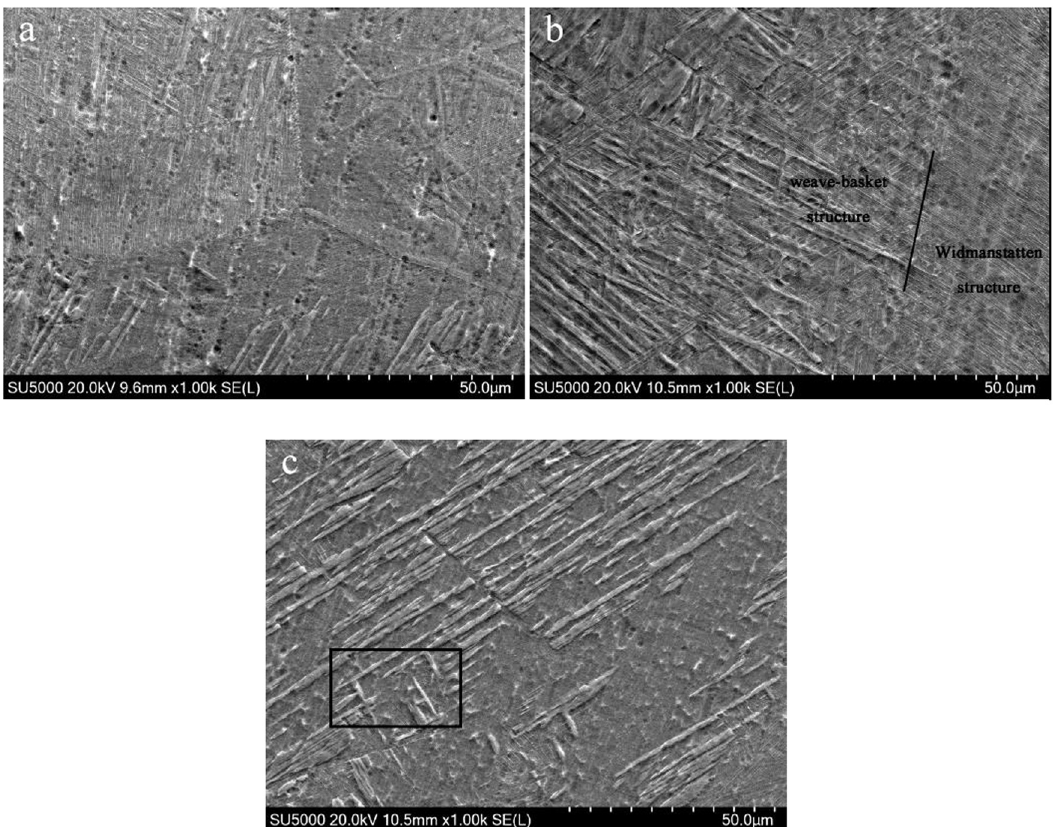
Figure 4: SEM of the samples at the strain rate of 0.001 s − 1 : ( a ) one - pass, ( b ) two - pass and ( c ) three - pass.